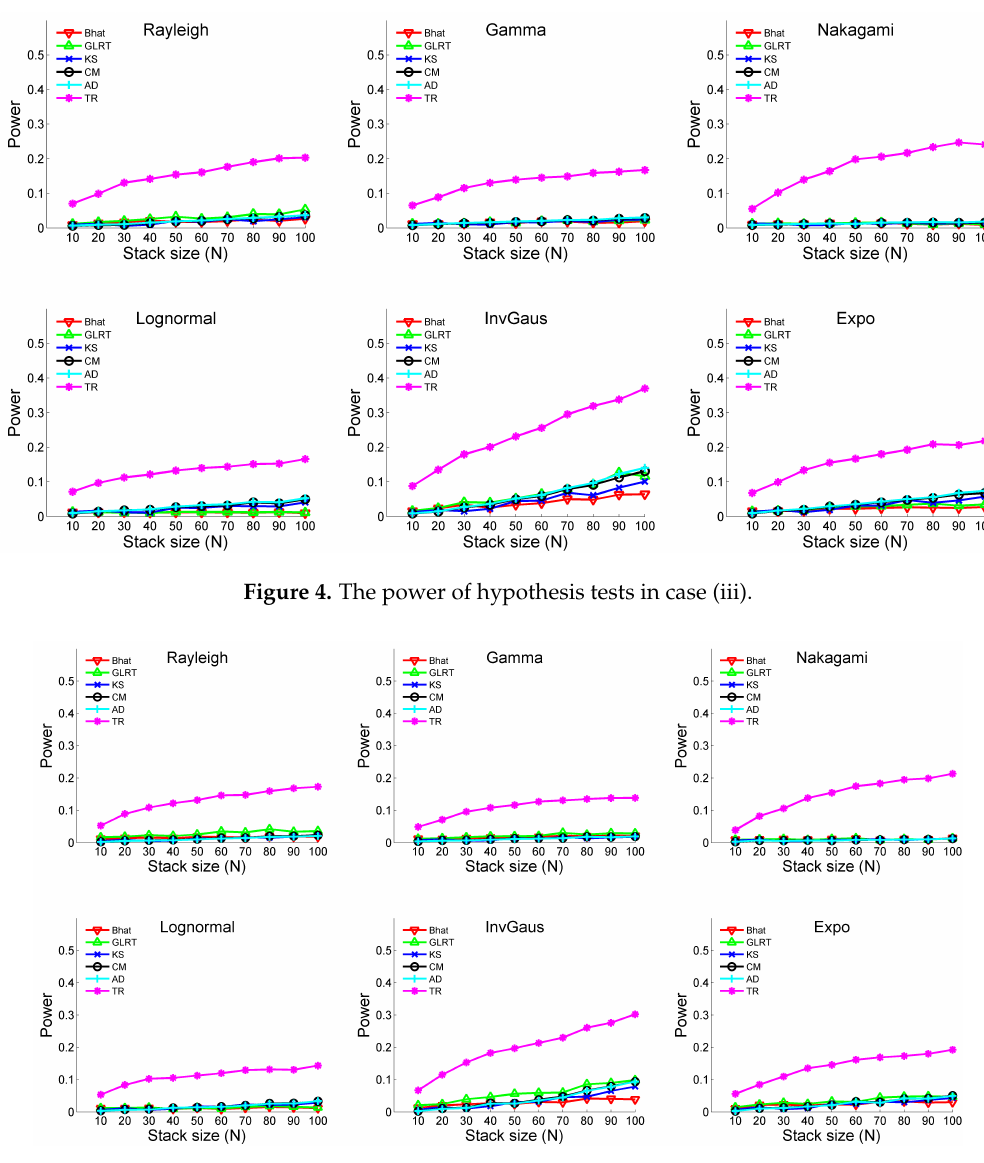
Figure 5. The power of hypothesis tests in case